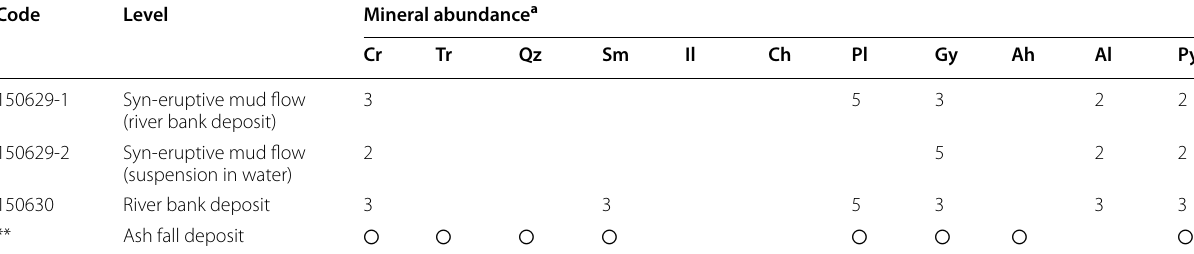
a See Table 1 for abbreviation and definition of abundance. ○ indicates detected. ** Yaguchi et al. (2019). No relative abundance is